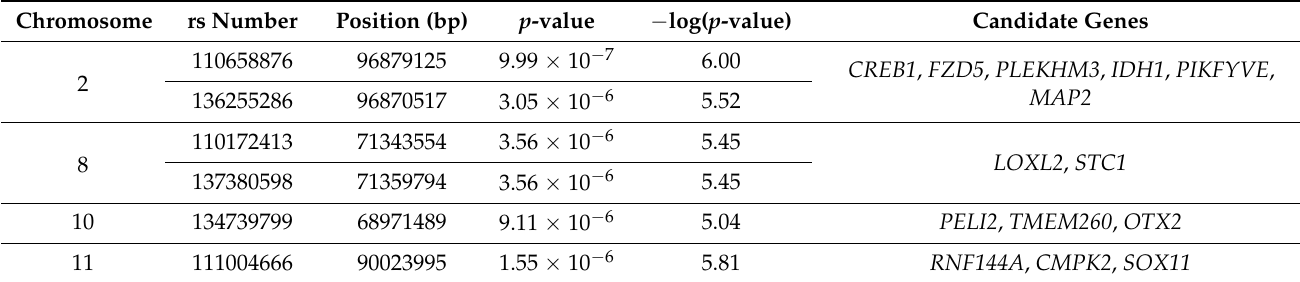
Figure 4. Manhattan plot of the GWAS for the variation in reproductive tract scores (RTS) in heifers in the left panel and the corresponding qq plots in the panel on the right. The solid line is at significance level –log( p -value) = 5. Table 2. Chromosome, rs number, position, p -value, –log( p -value) and candidate genes for significant SNPs associated with the RTS.